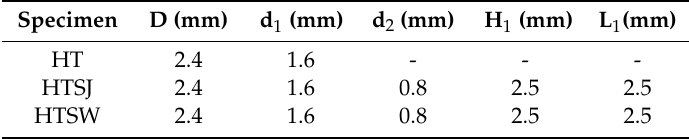
Table 1. Details of design parameters of the specimens.